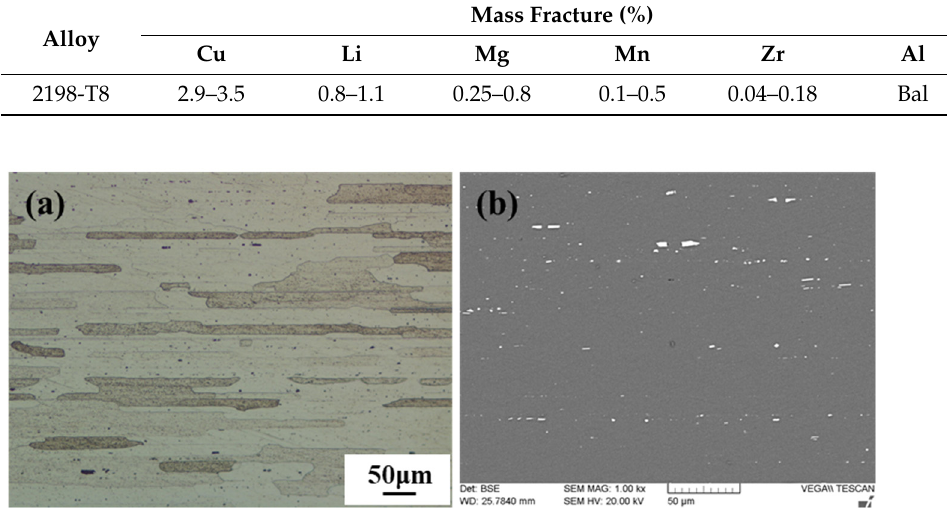
Figure 1. Microstructure of base material (2198 Al–Li alloy): ( a ) Microstructure; ( b ) precipitated phase